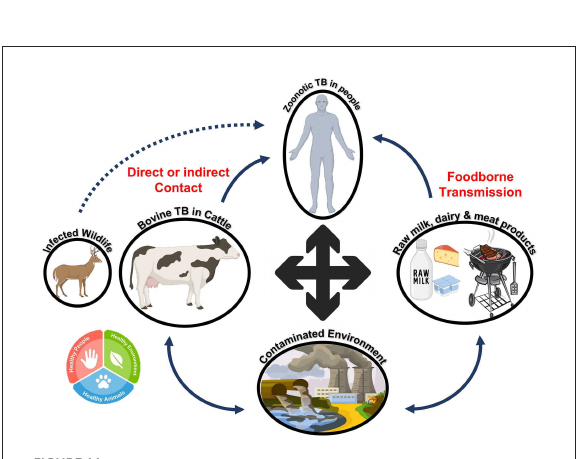
FIGURE11 Reservoir and transmission of zoonotic tuberculosis. Bovine tuberculosis can be transmitted to humans directly or through contaminated dairy or meat products. The pathogen can survive in the environment and then enter the food chain, resulting in tuberculosis in humans after transmission.